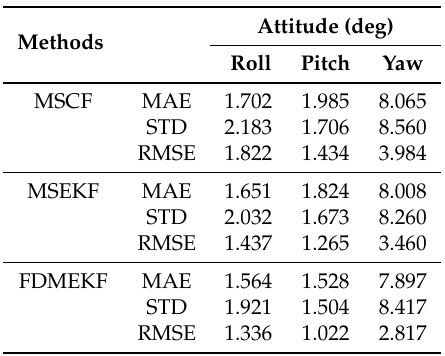
Figure 8. The attitude error of the UAV in flight. ( a ) the roll error of the UAV; ( b ) the pitch error of the UAV; ( c ) the yaw error of the UAV. Table 1. Mean absolute errors (MAE), standard deviations (STD), and root mean square errors (RMSE) of the attitude achieved by multisensor complementary filtering (MSCF), multisensor EKF (MSEKF), and the federated double-model EKF (FDMEKF) for the experimental